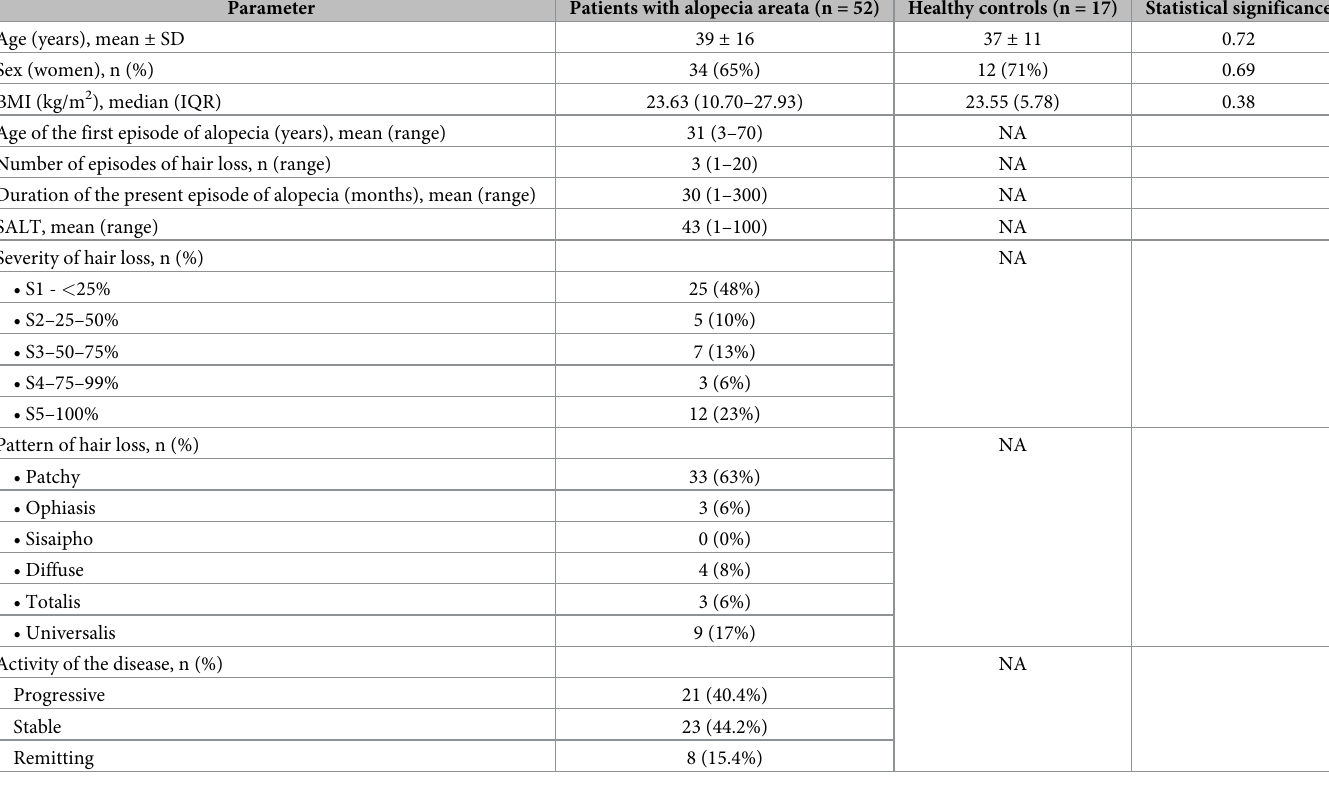
Table 1. Demographic and clinical characteristics of patients with alopecia areata and healthy controls.